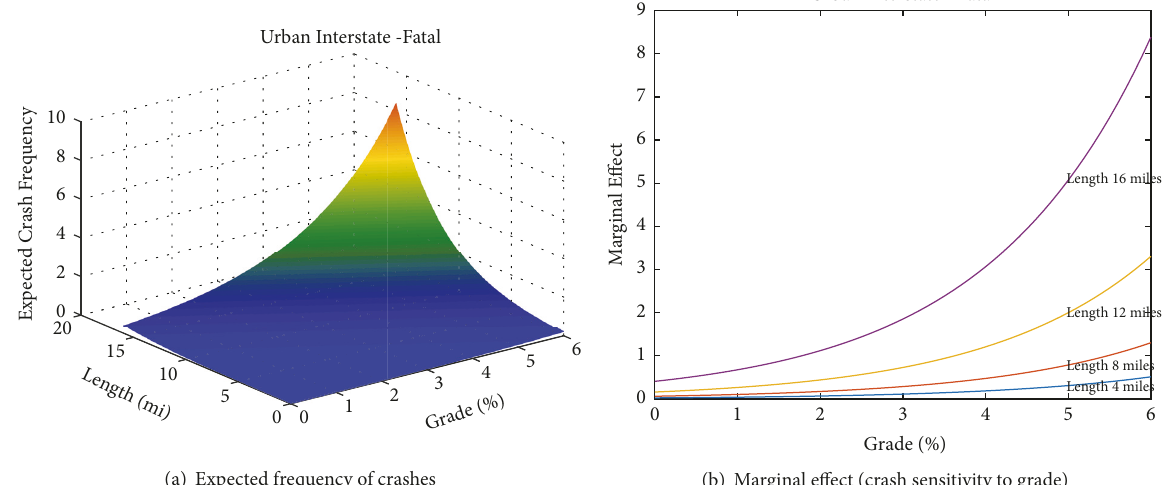
Figure 4: Urban interstate fatal